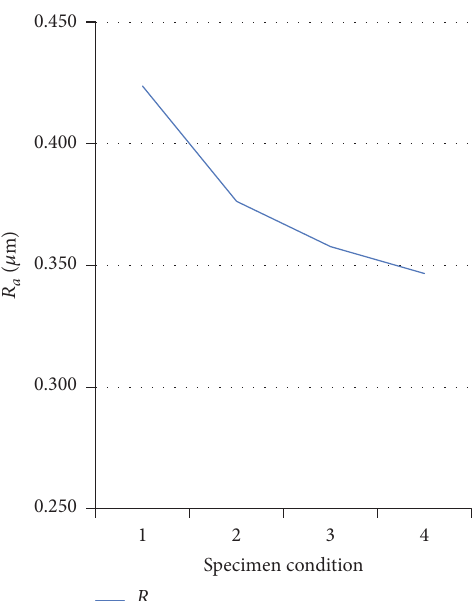
Figure 3: Surface roughness, 𝑅 𝑎 ( 𝜇 m) versus specimen condition.